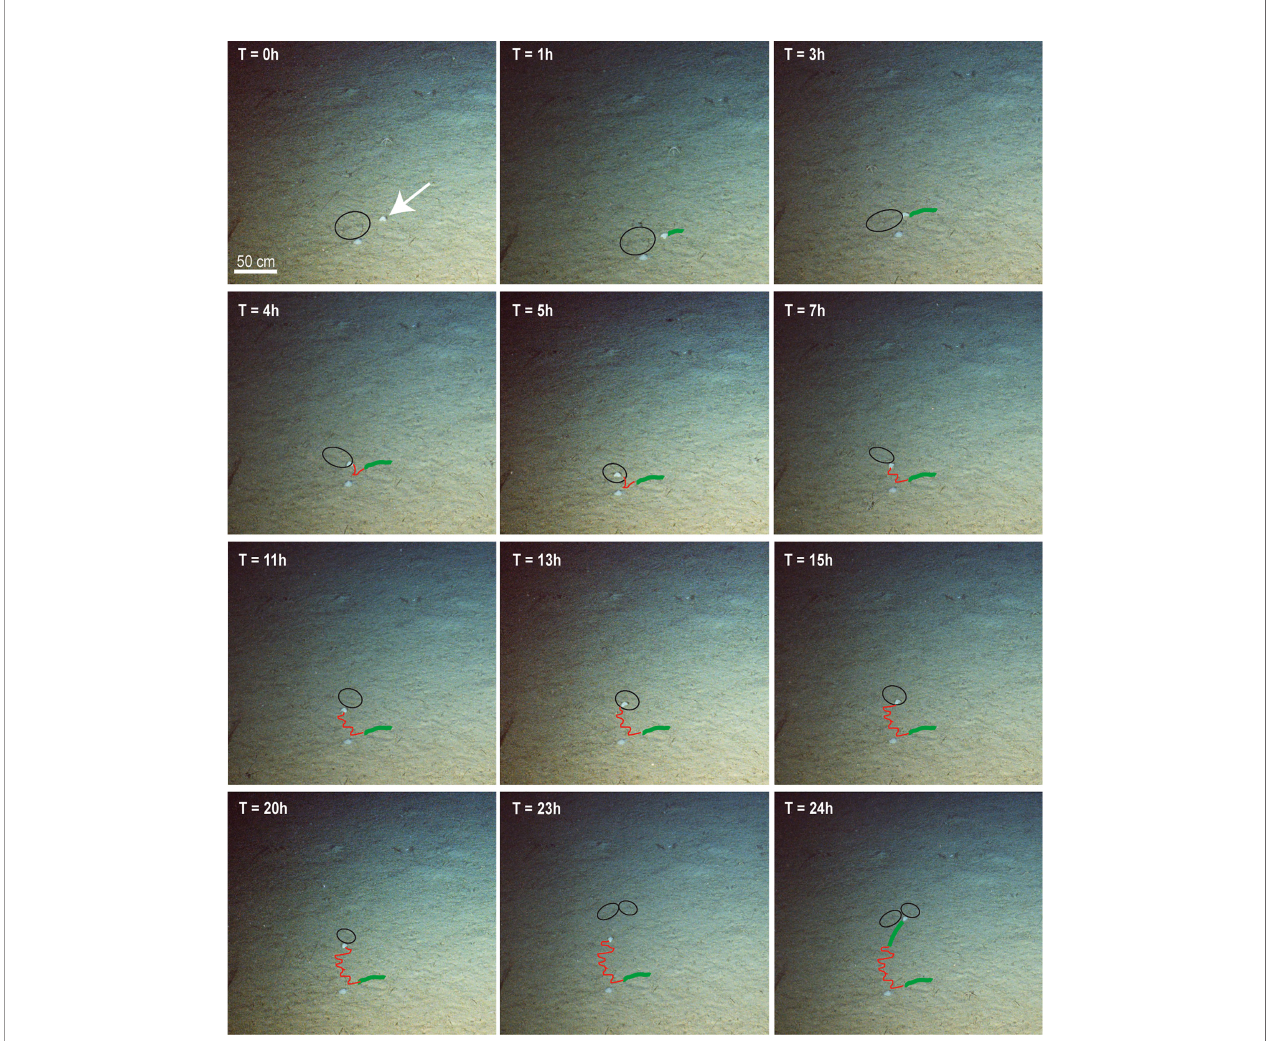
FIGURE 3 | A sequence of images (hourly) that record the movement pattern of E . rostrata (white arrow) and the distribution of organic matter patches consumed by the echinoid (black circles). Note the Run (thick green line; T = 23h to T = 24h) and Mill (thin red line; T = 11h to T = 15h) behaviors of E . rostrata ( sensu Kaufmann and Smith,